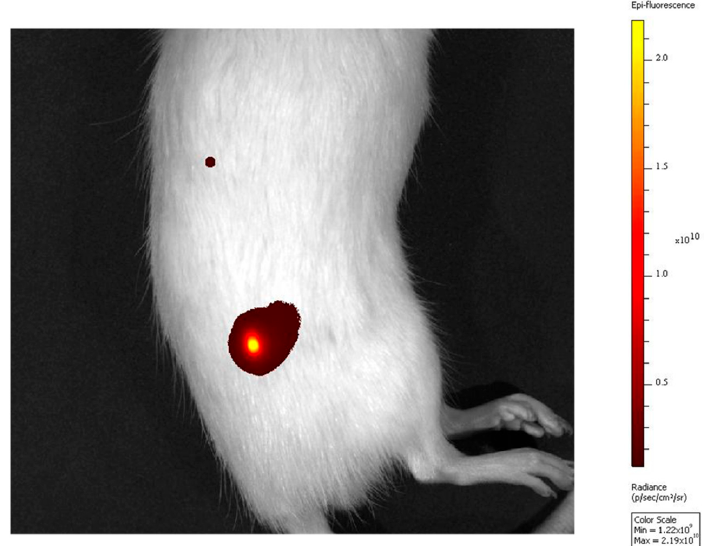
Figure 13. Epifluorescence of the AuNP solution was detected surrounding the injection sight in the